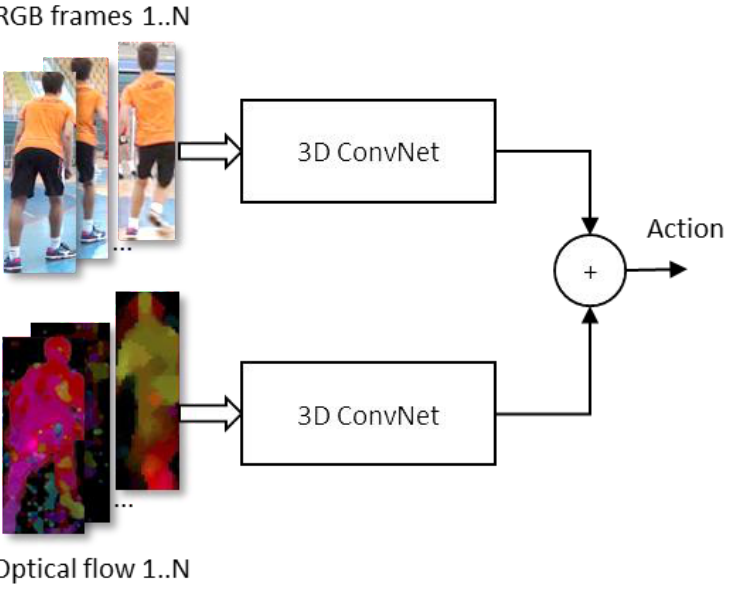
Figure 4. Overview of I3D model architecture.